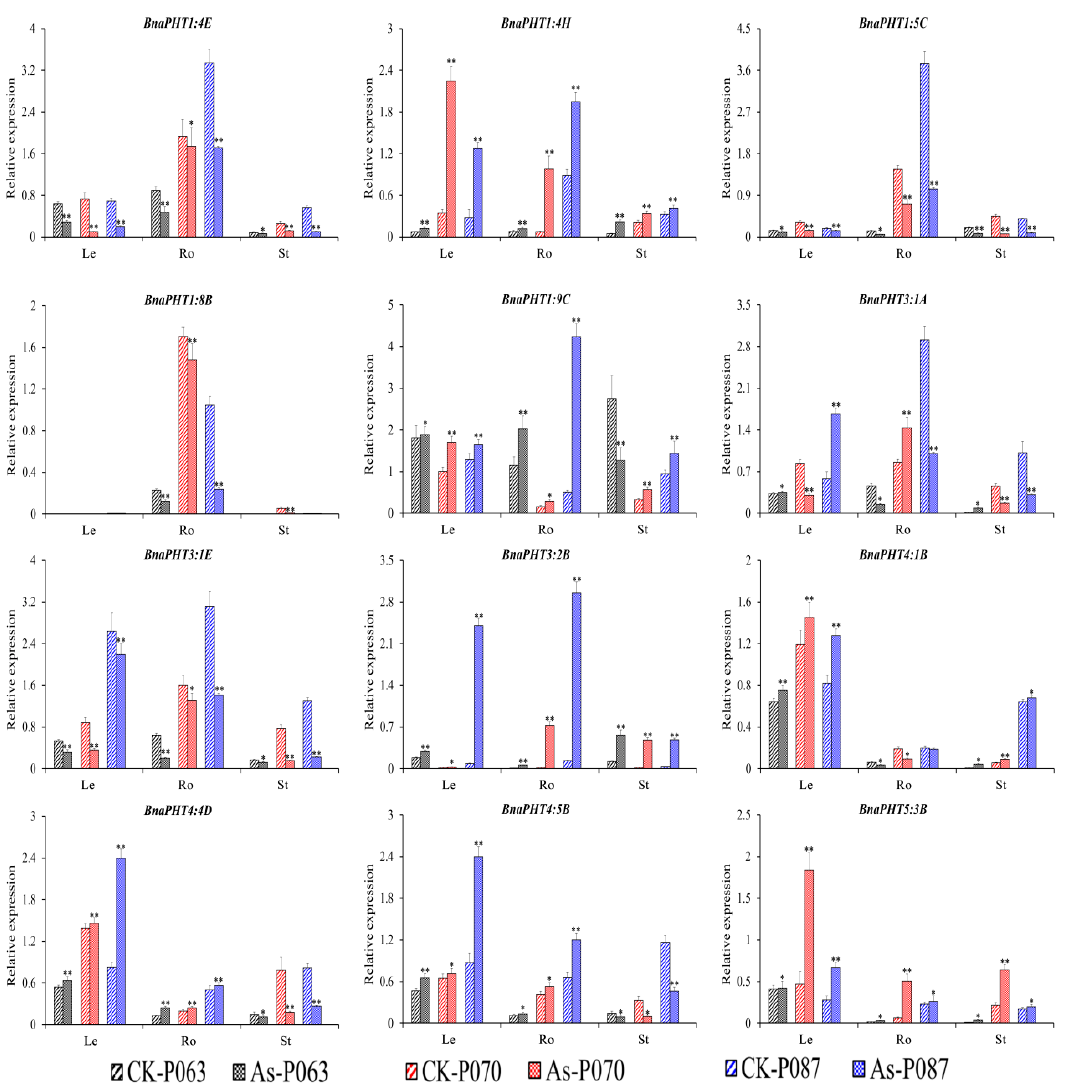
Figure 7. Expression profiles of 12 BnaPHT genes in B . napus under As 3+ treatment, as revealed by qRT-PCR. The CK is the control sample, and As represents samples treated with As 3+ stress. The samples (P063, P070, and P087) are B . napus accessions. Error bars show the standard deviation of three biological replicates. Single and double asterisks represent significant differences from the control sample at the 0.05 and 0.01 levels (t-test), respectively.